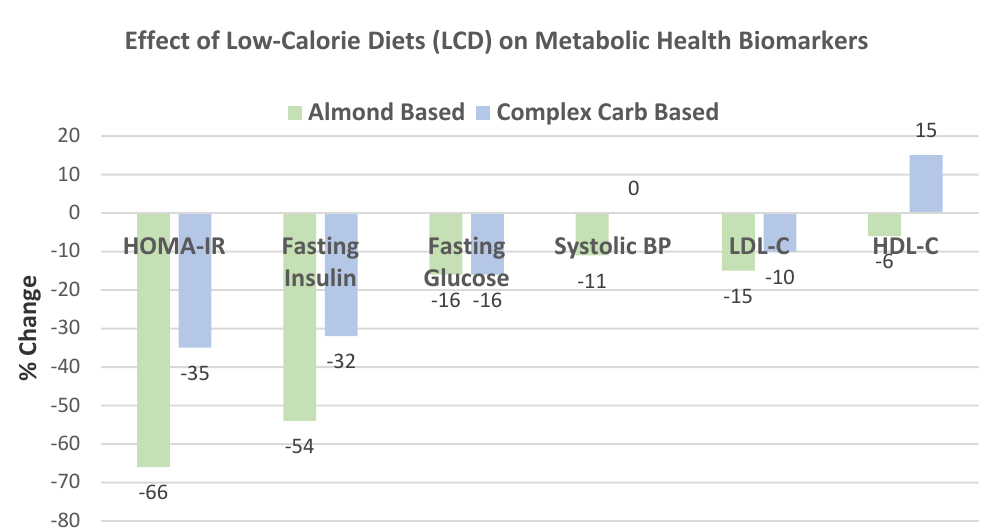
Figure 37. Summary of effects of almond-enriched and complex carb-based LCDs on metabolic outcomes from baseline to 24 weeks: almond vs. complex carb LCD change in HOMA-IR, fasting insulin and glucose, and LDL-C ( p < 0.0001), systolic BP ( p < 0.01), and HDL-C ( p < 0.05) [65].